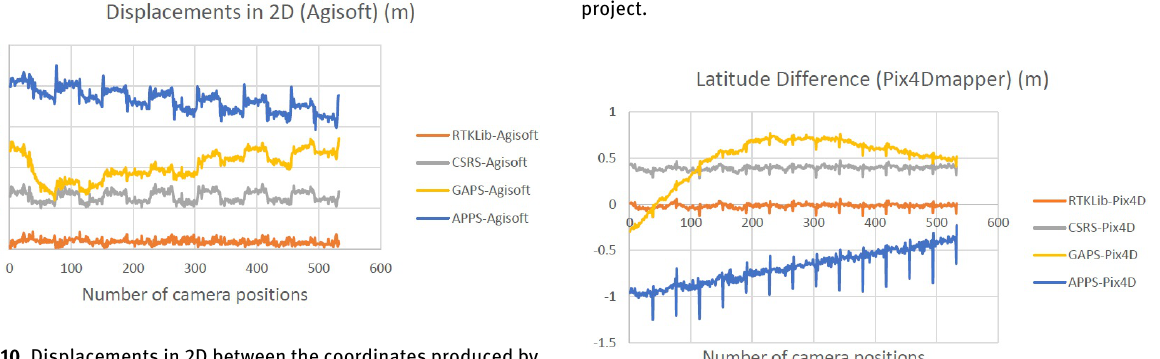
Fig. 10. Displacements in 2D between the coordinates produced by Agisoft Metashape and the software utilized in this project. Because 2D results were obtained using the latitude and longitude results displayed above, the results in Table 3 follow the results in Tables 1 and 2.